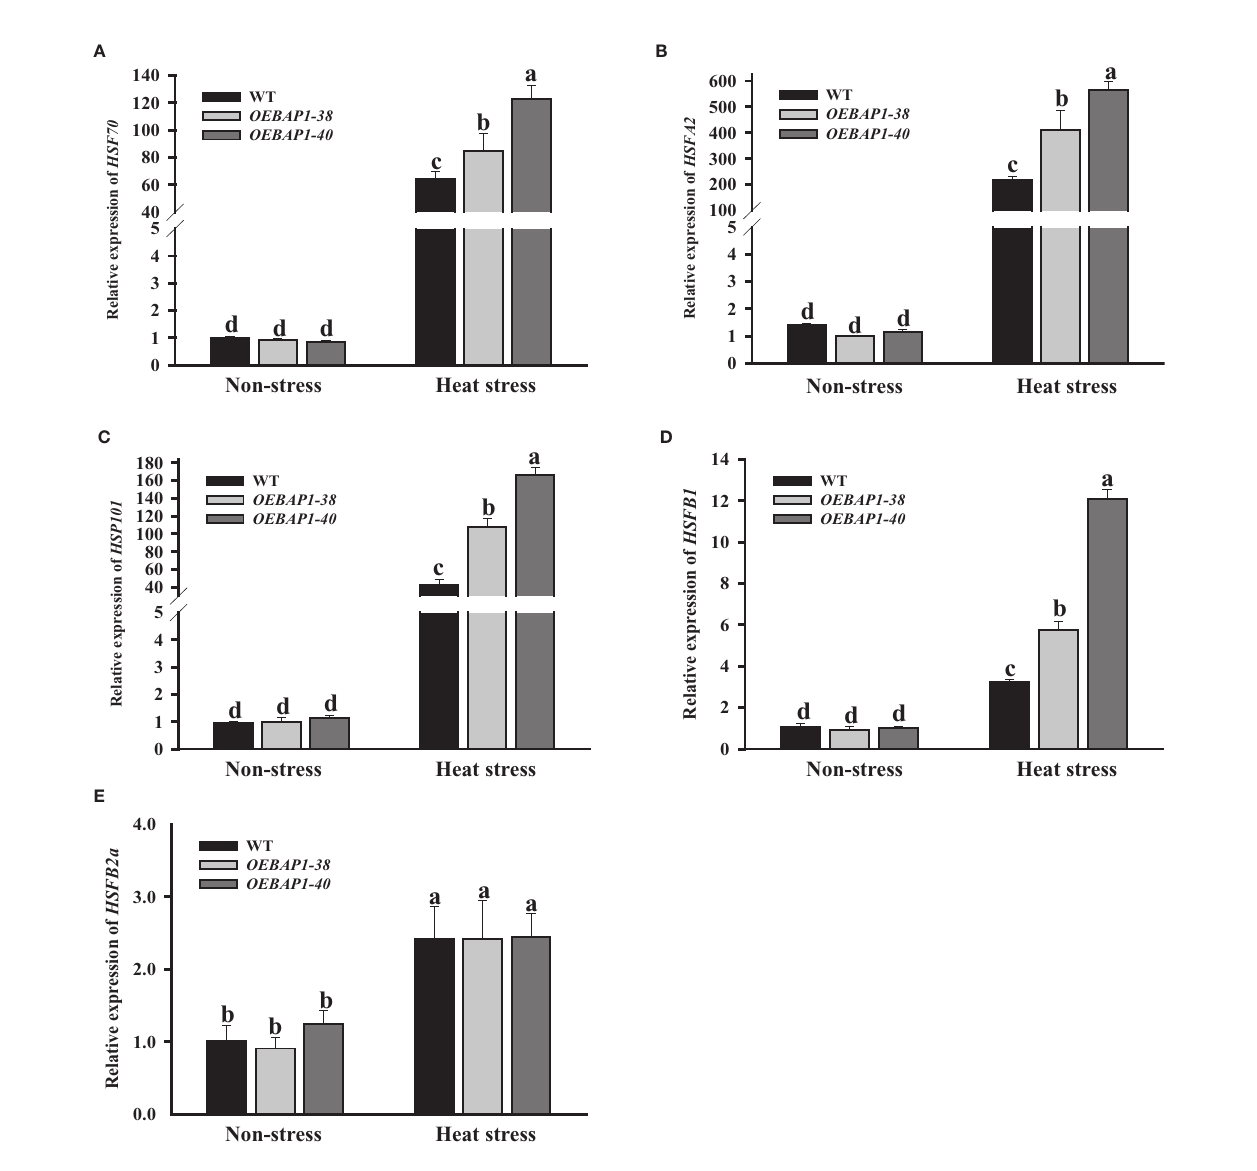
FIGURE 6 | Effects of heat stress on the expression of heat-related genes in VvBAP1- overexpressing Arabidopsis leaves. The expression of HSP70 (A) , HSP101 (B) , HSAFA2 (C) , HSAFB1 (D ) and HSFB2a (E) in the leaves of overexpressing lines under heat stress (45°C for 2 h). Each experiment was conducted thrice. Values are the means ± SE of three independent experiments (P < 0.05). Lower-case letters above bars denote signi fi cant differences attested by Tukey ’ s HSD